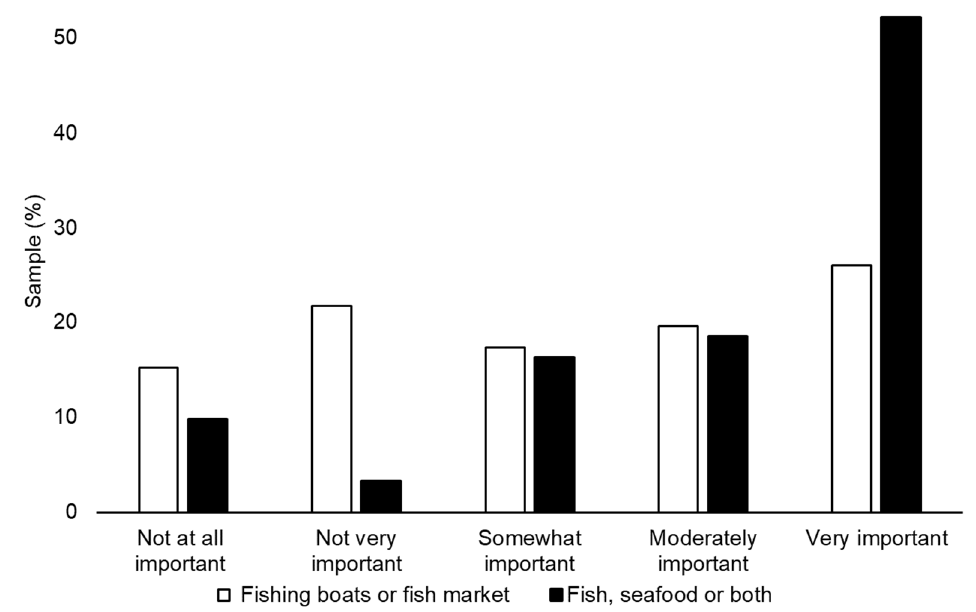
Figure 1. Distribution of responses indicating the relative importance of seeing the fishing boats or the fish market, and purchasing fish, seafood or both to the trip.